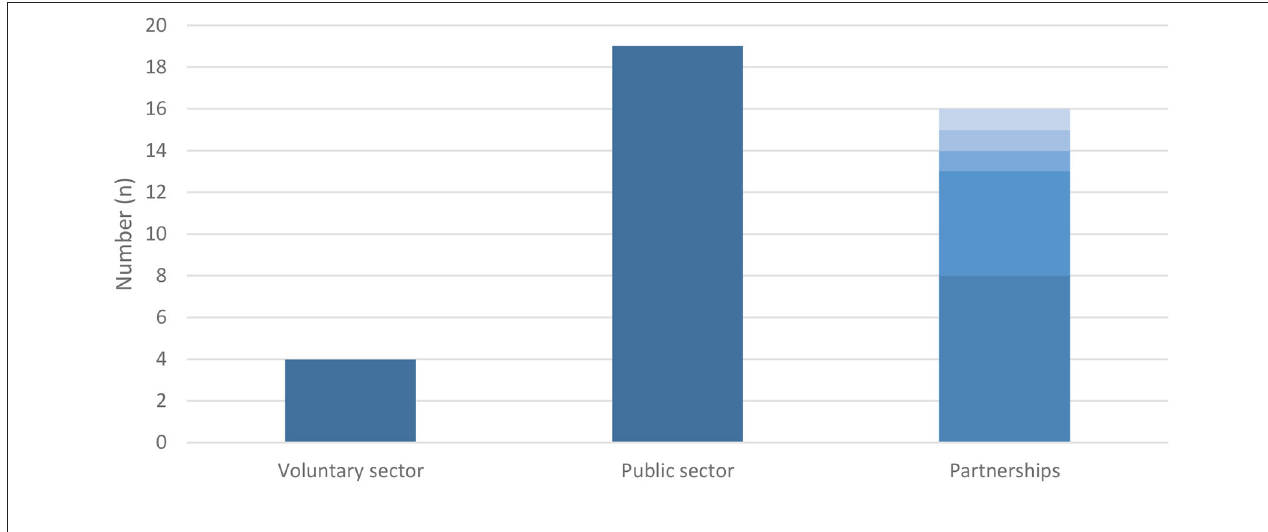
FIGURE 4 | Distribution of project